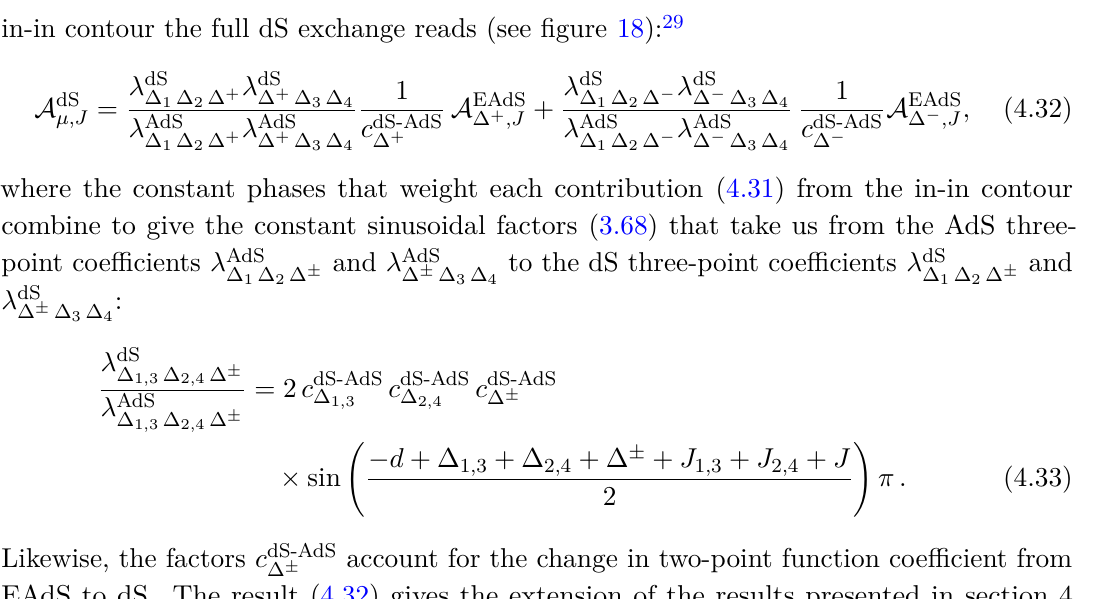
/λ AdS account ∆ 1 , 3 ∆ 2 , 4 ∆ ± ∆ 1 , 3 ∆ 2 , 4 ∆ ± for the change in two-point ∆ ±